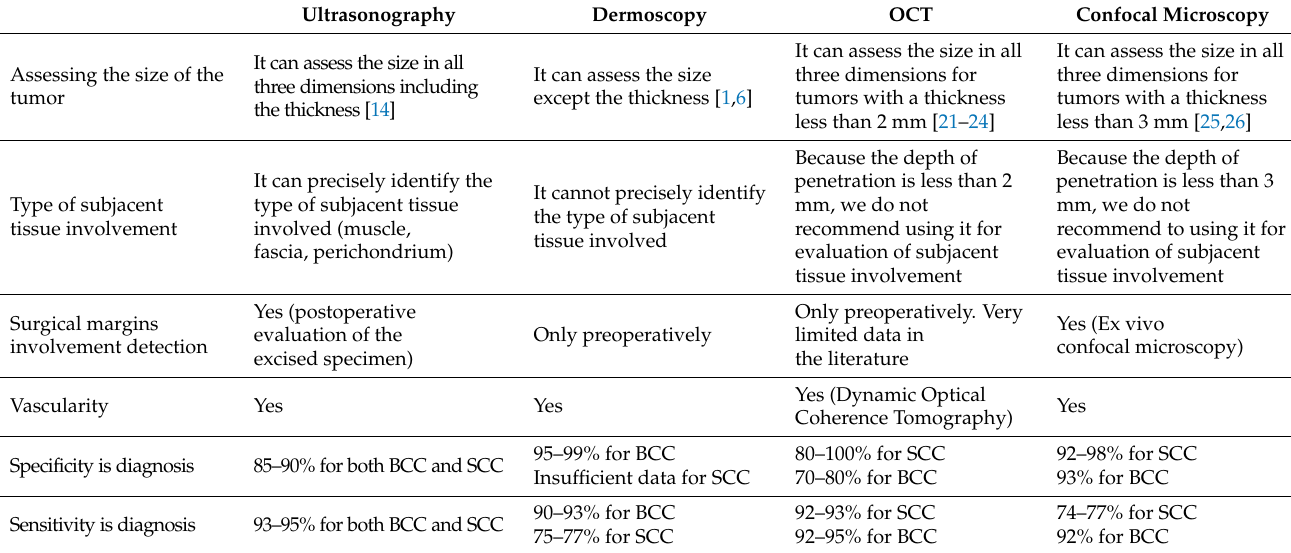
Table 1. Characteristics of different non-invasive tehniques used for evaluation of